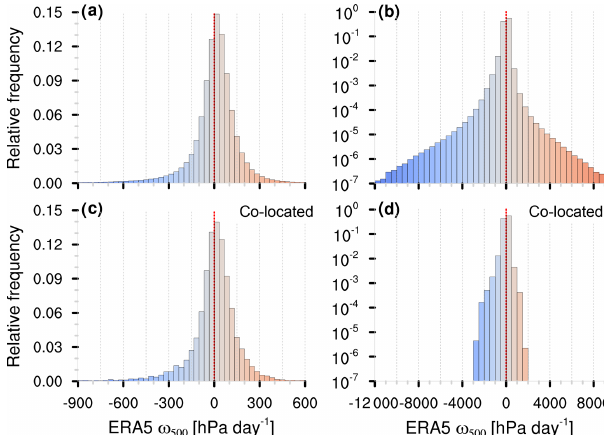
Figure 4. Histograms of relative frequencies for ω 500 (blue: rising motion; red: subsiding motion) of (a, b) all ERA5 grid boxes and (c, d) for OceanRAIN–ERA5 co-located ERA5 grid boxes with (a, c) linear ordinates and (b, d) logarithmic ordinates for strong mo-